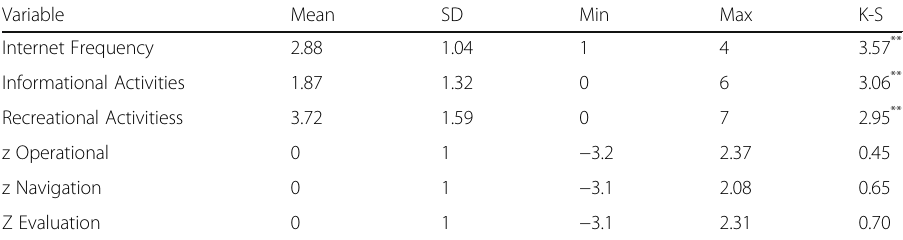
Table 2 Descriptive statistics for internet skills, internet frequency, and online informational and recreational activities